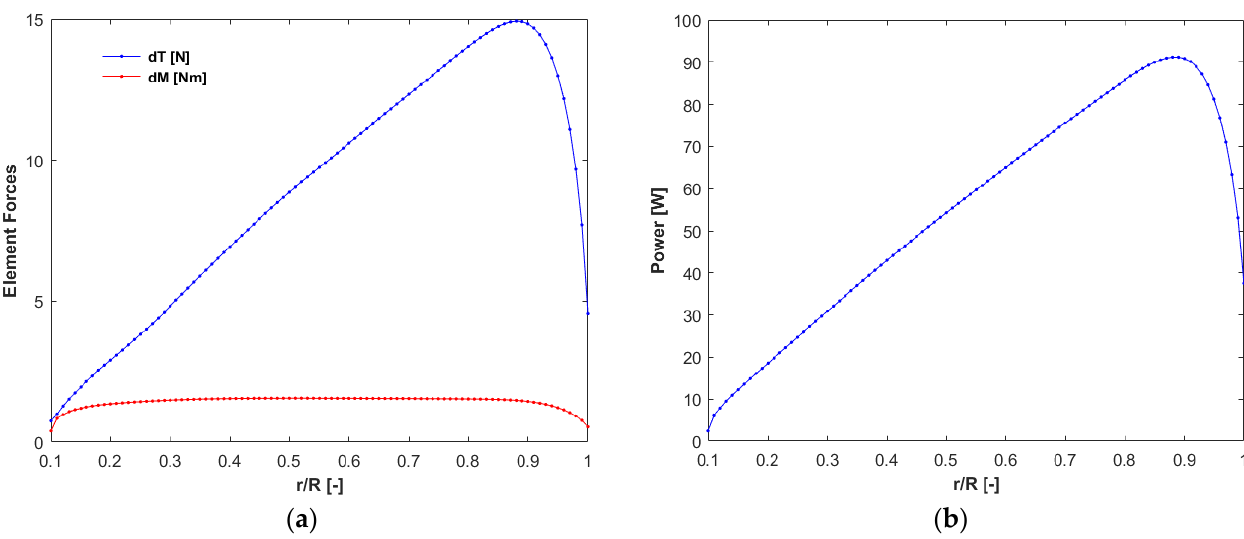
Figure 7. Element forces and power along the normalized radius of the designed blade at a wind speed of 10 m/s. ( a ) Element thrust and torque vs. normalized radius. ( b ) Element power vs. nor- malized radius. vs. normalized radius.